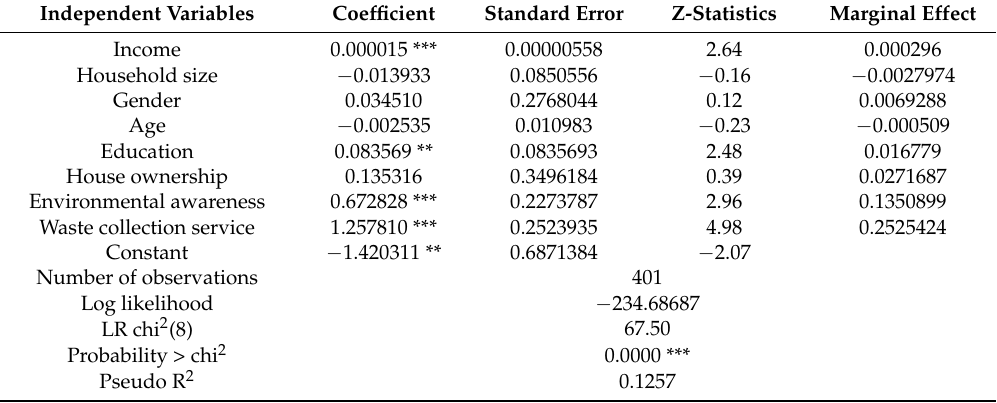
Table 6. Logit regression results of factors influencing willingness to pay for improved waste collection service. Independent